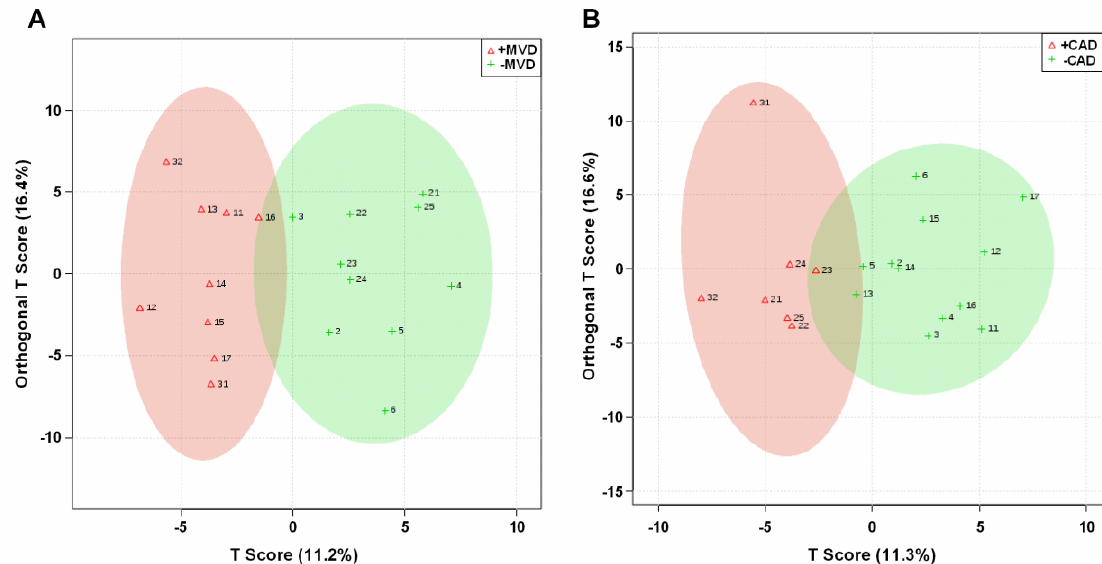
Figure 2. Partial least squares discriminant analysis (OPLS-DA) of plasma lipidomic profile discriminates between ( A ) participants with or without MVD and ( B ) participants with or without CAD. Signal intensities of 178 individual lipid species were normalized (quantile normalized), scaled (pareto scaling) and centered and then analyzed using OPLS-DA. The ellipses are drawn at 95% CI of normal distribution for a given group. Loading plots illustrate the proportion of variation accounted for by each component. Each number stands for one participant (1 to 6 for -MVD/-CAD, 11 to 17 for +MVD/-CAD, 21 to 25 for -MVD/+CAD, and 31 to 32 for +MVD/+CAD).